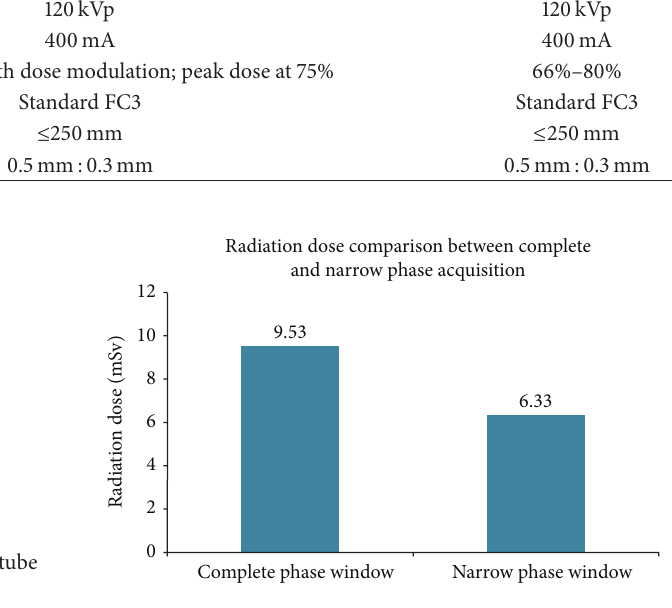
Figure3:Radiationdosecomparisonbetweencompleteandnarrow phase window acquisition at 320-row